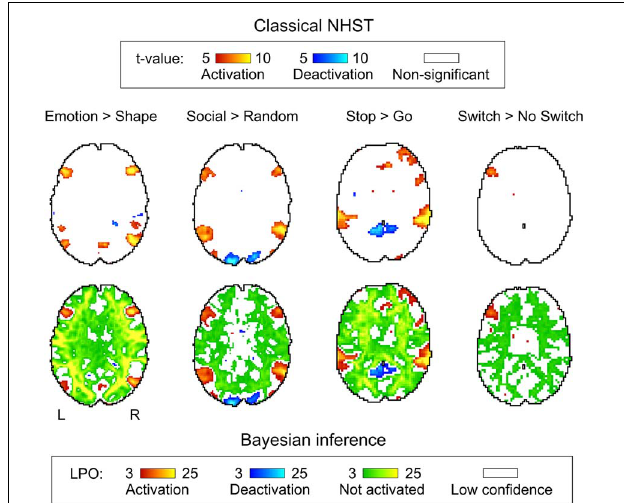
FIGURE 6 | Examples of results obtained with classical NHST and BPI. Four contrasts were chosen for the illustration purposes (two event-related and two block-design tasks). Classical NHST was implemented using voxel-wise FWE correction ( α = 0.05). BPI was implemented using the ‘ROPE-only’ decision rule, P thr = 95% ( LPO > 3) and γ = 1 prior SD θ . Axial slice z = 18 mm (MNI152 standard